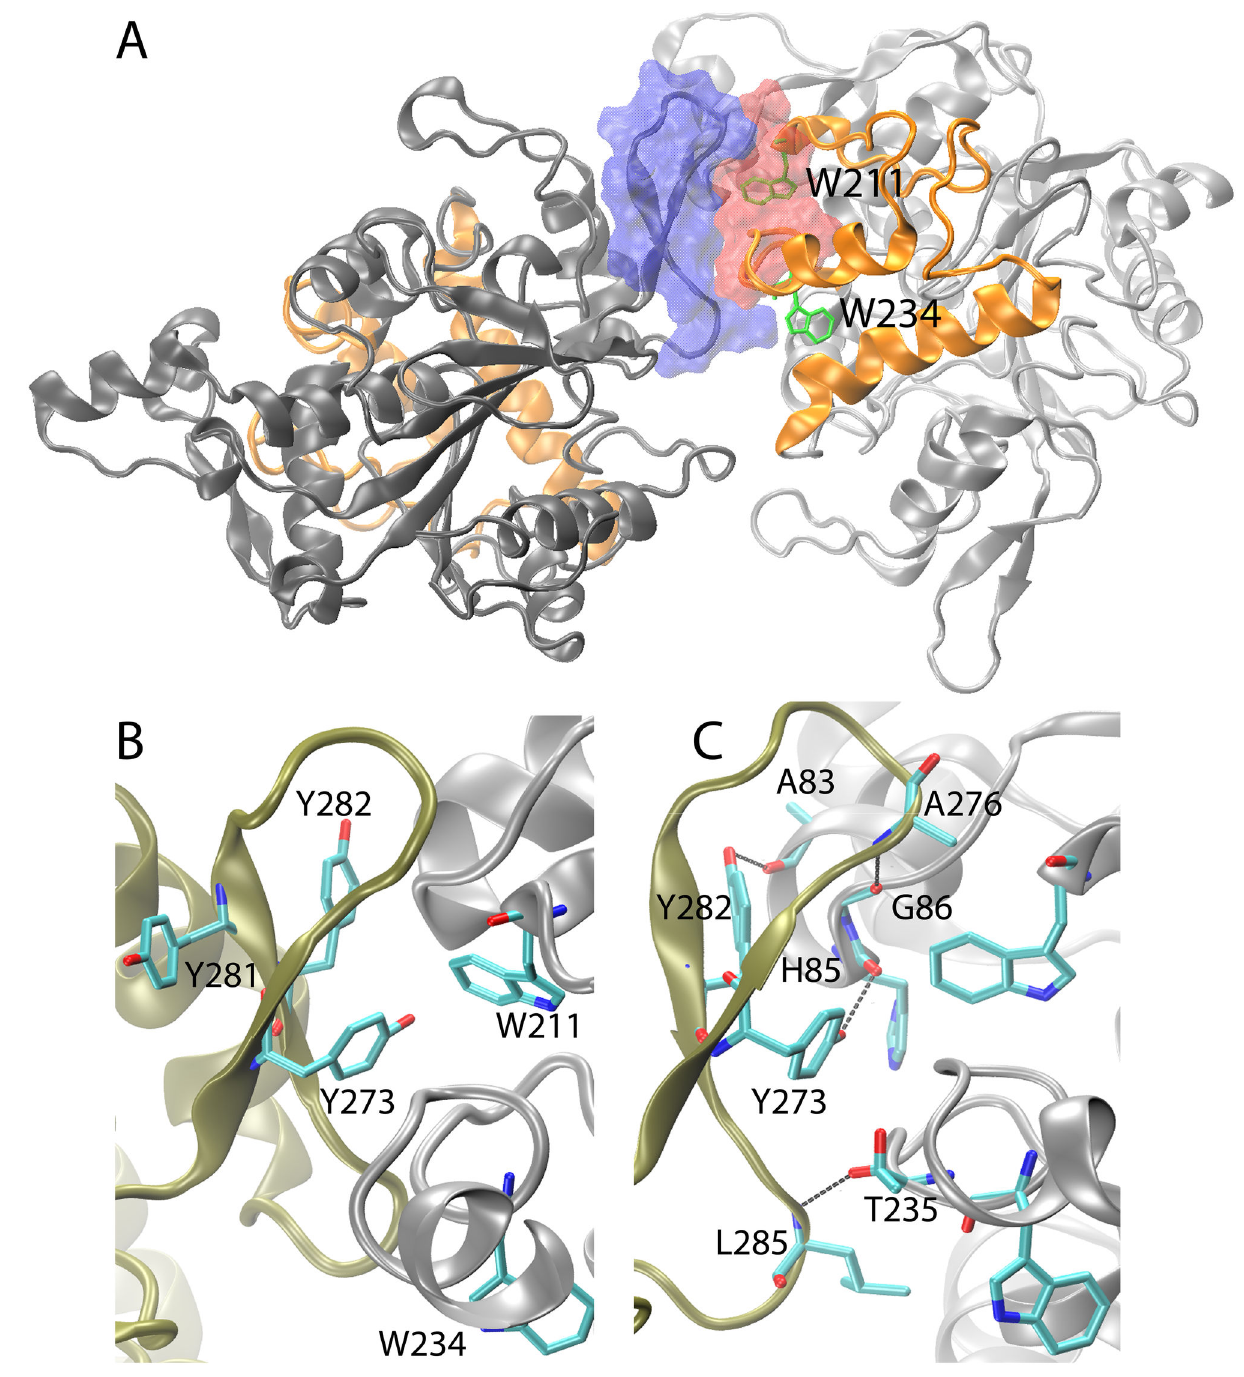
Figure 5. Crystal structure of the dimer BTL2. Two subunits, chain A and B are shown in black and silver, respectively, where the lids are colored in orange for both. The subunit interface is rendered by van der Waals surface: blue for chain A and red for chain B. The lid tryptophans W211 and W234 are shown in green sticks. (B) The aromatic cluster and (C) the network of hydrogen bonds were shown in stick models (C: cyan, N: blue, O: red).